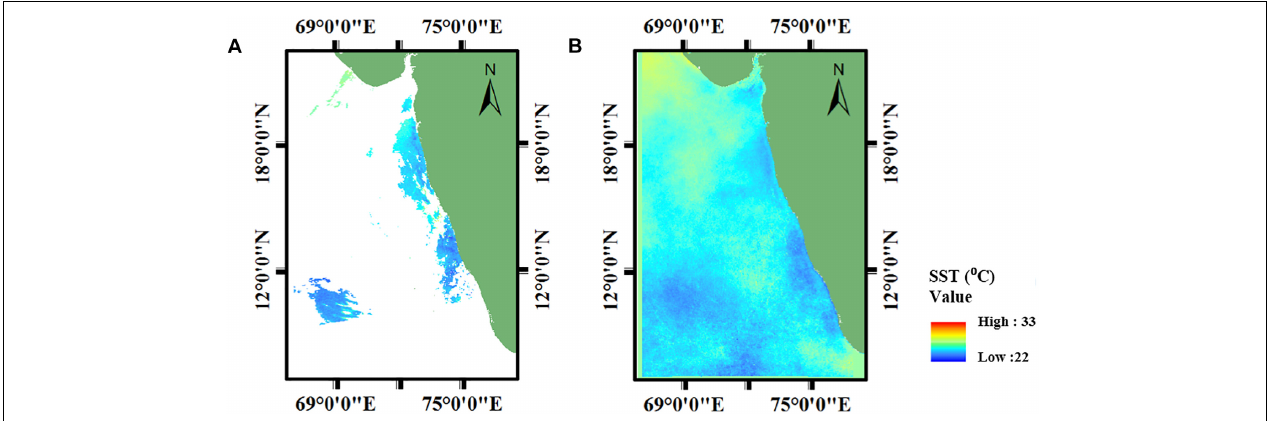
FIGURE 13 | Illustrative example for user case study 3 (A) The MODIS Aqua image with gaps. (B) Reconstructed SST image using DINEOF, both corresponding to the date November 30, 2015.